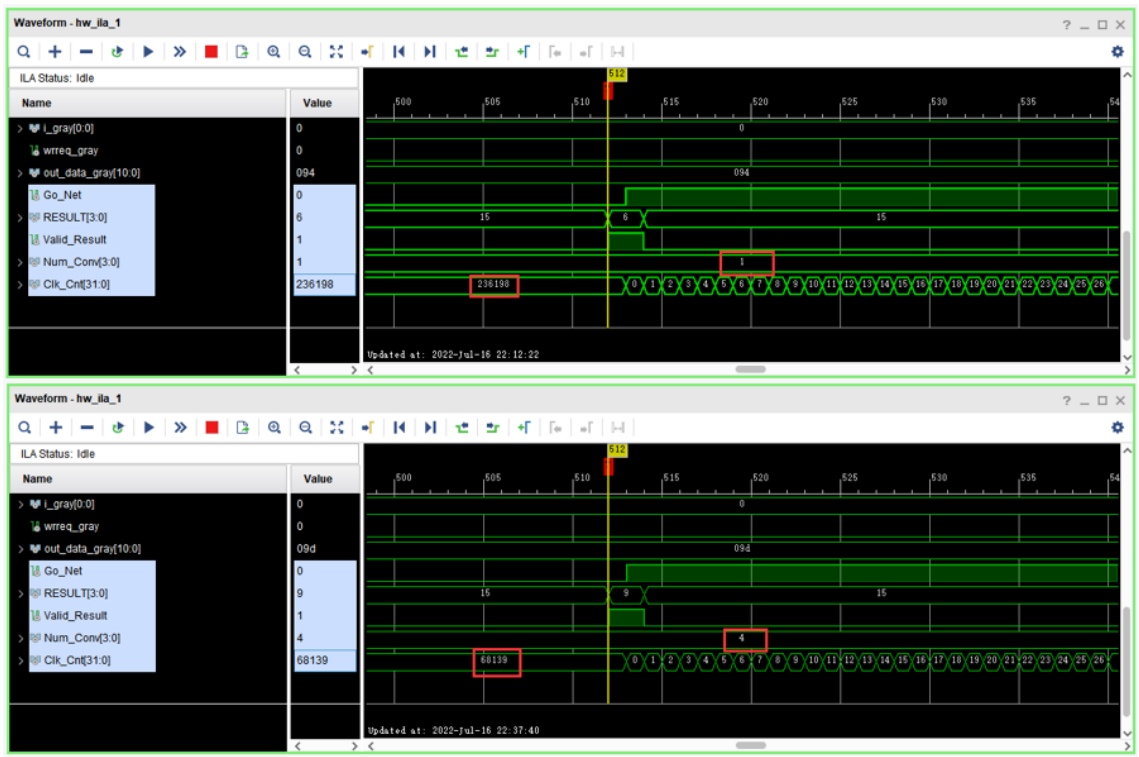
Figure 18. Predicted latency simulation